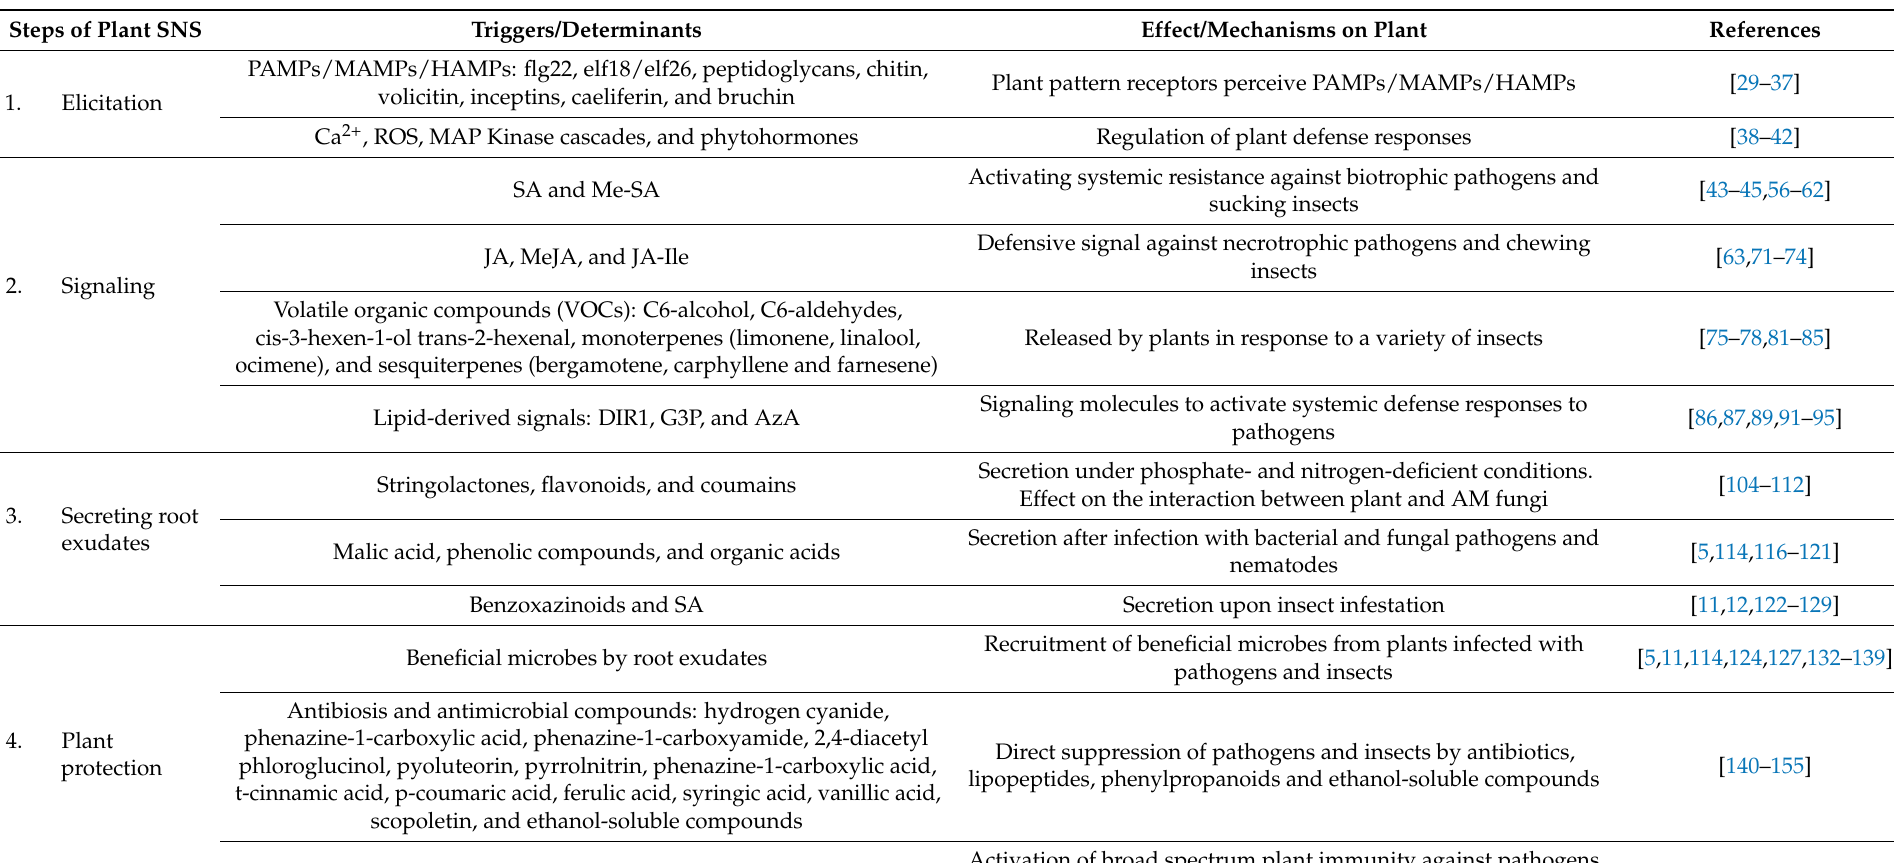
Table 1. Summary of plant SNS steps described in this